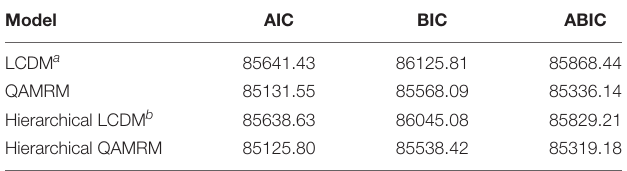
TABLE 2 | Bias and 95% coverage rate for the item parameters in the simulation study. TABLE 4 | Comparisons of model-data fit among the QAMRM,